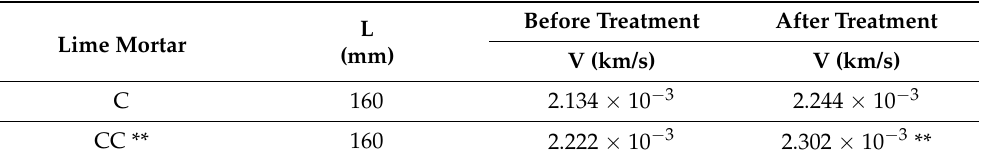
Table 14. Comparison between the values of the impulse propagation rates before and after treatment of lime mortar samples (mean values).